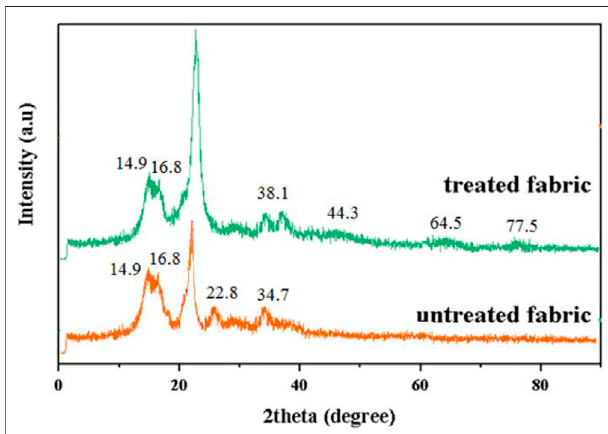
FIGURE 7 | X-ray diffraction (XRD) analysis of cotton and treated cotton with MS + 10% TA +